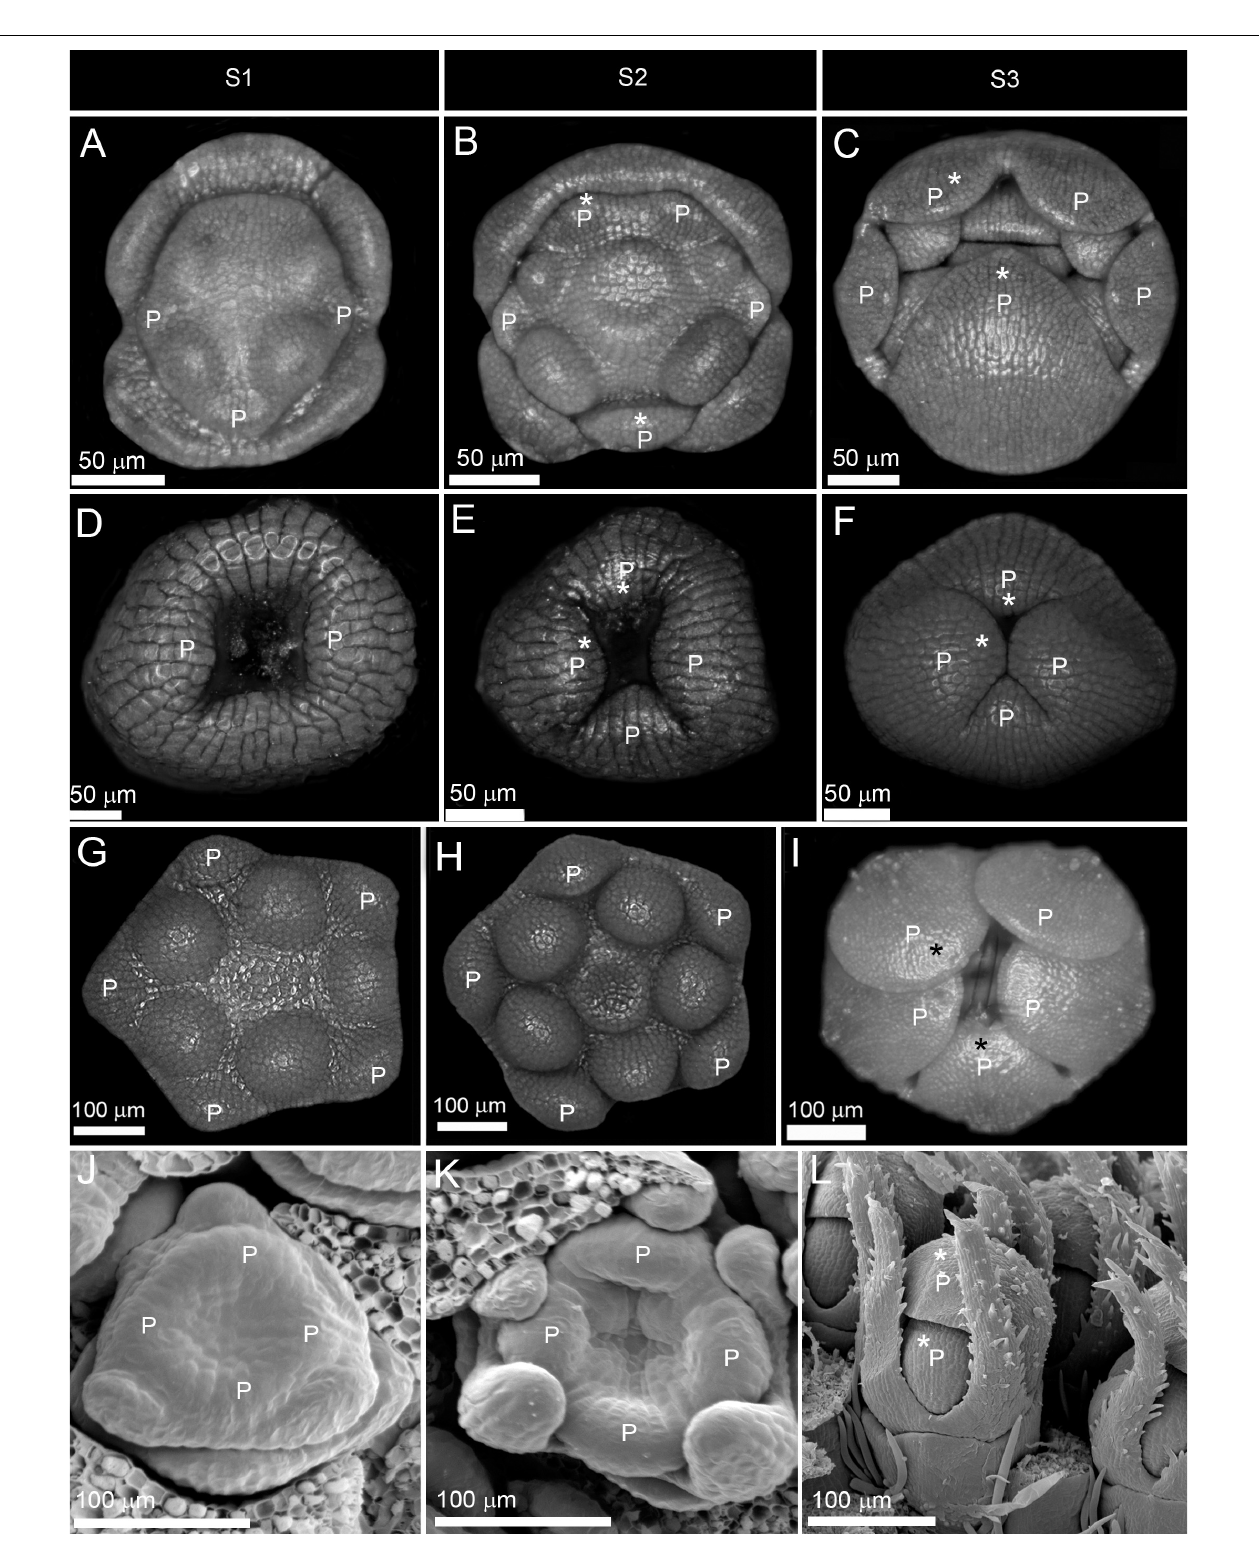
FIGURE 3 | Early and late establishment of zygomorphy in corolla. (A–F) Non-simultaneous initiation followed by asynchronous enlargement and differentiation in Salvia nemorosa from Lamiaceae (A–C) and ray florets of Osteospermum ecklonis from Asteraceae (D–F) . (G–L) Simultaneous initiation followed by synchronous enlargement and asynchronous differentiation in Verbascum thapsus from Scrophulariaceae (G–I) and Succisa pratensis from Caprifoliaceae (J–L) . P: petal, S1: initiation phase, S2: enlargement phase, S3: differentiation phase. Note the size difference between the largest and the smallest corolla members during asynchronous enlargement and differentiation (shown by